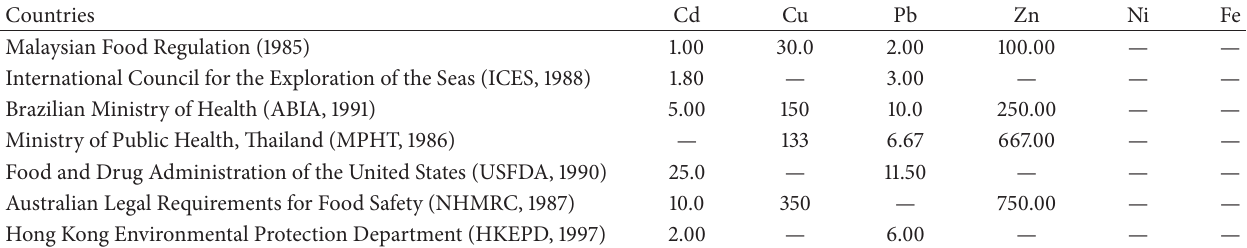
Table 2: Guidelines on heavy metals ( 𝜇 g/g dry weight) for food safety set by different countries [27–38]. Countries Malaysian Food Regulation